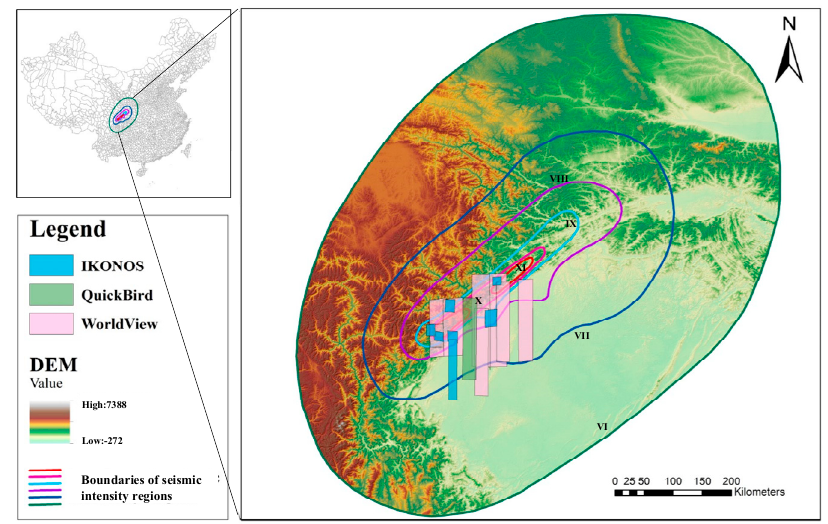
Figure 1. Historical images captured within seven days of the Wenchuan earthquake.